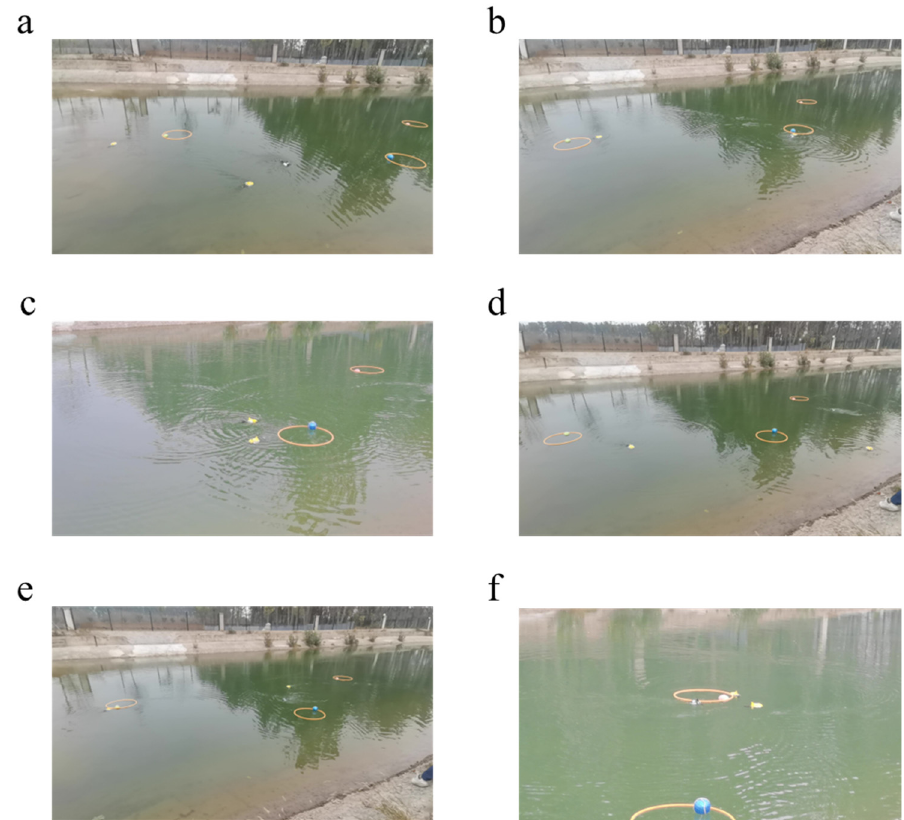
Figure 4. Swarm game for autonomous underwater robots (three targets, two altruistic, and one selfish robot). This figure shows snapshots of our experiment over time. The time starts from the beginning of the experiment. Different panels correspond to different times: (a) t=20s; (b) t=40s; (c) t=60s; (d) t=80s; (e) t=100s; (f) t=140s.